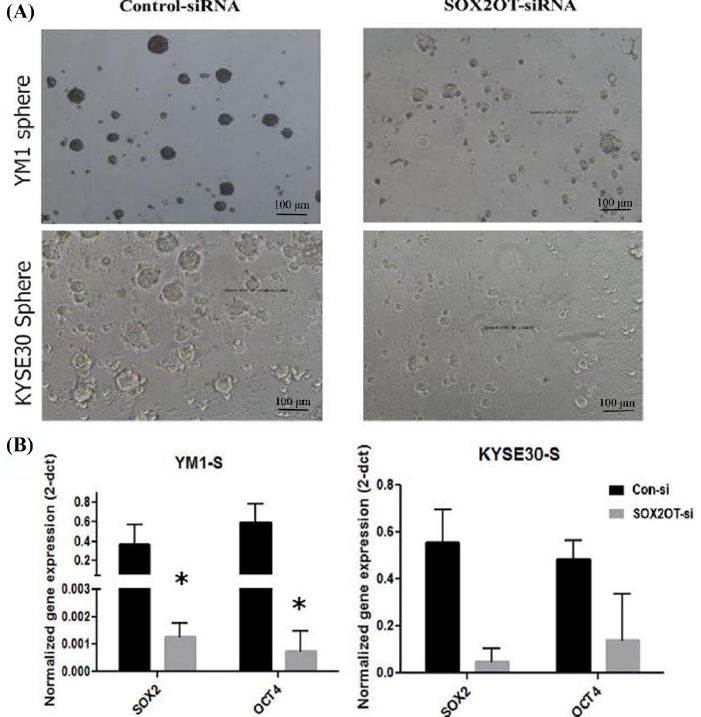
Figure 5. Downregulation of SOX2OT in YM1 and KYSE30 tumorspheres. ( A ) shows the phenotype of the tumorspheres of each cell line after SOX2OT siRNA or control non-target siRNA transfection. ( B ) shows the decreased expression of pluripotency genes in SOX2OT knocked down tumorspheres. YM1: * p -value = 0.05 (SOX2, OCT4A) and KYSE30: p -value = 0.064 SOX2, p -value = 0.083 OCT4A and bars represent mean ± SE.